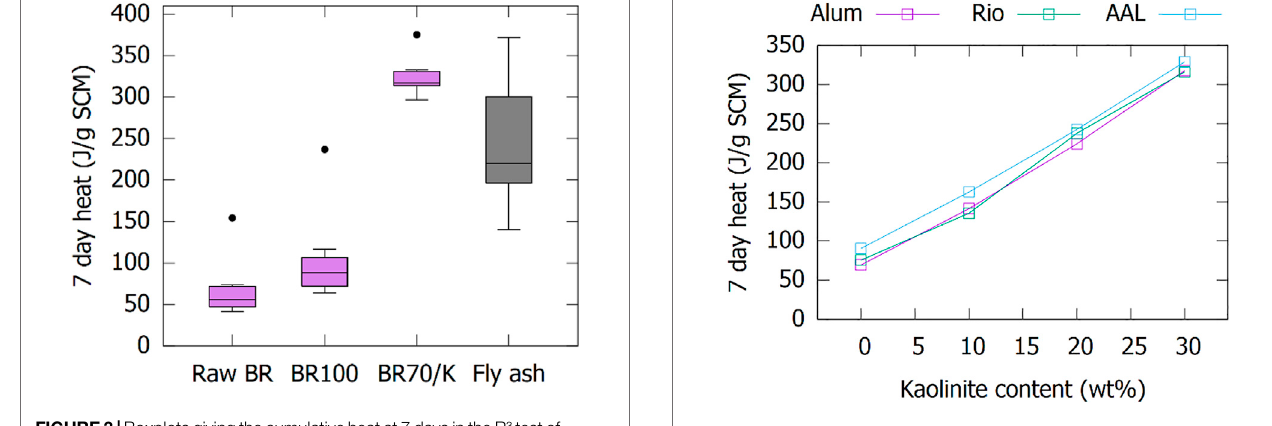
Frontiers in Materials |